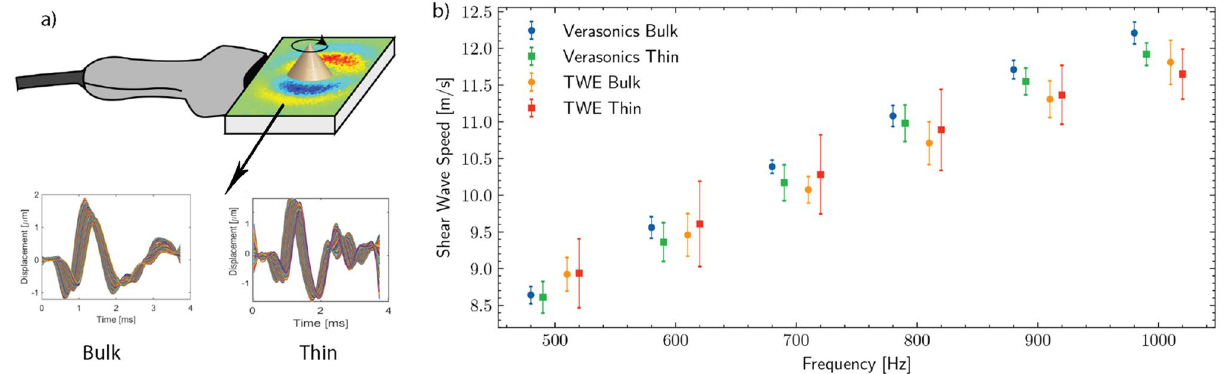
Figure 4. Exploring the torsional wave propagation under different geometries: ( a ) Shear wave imaging was performed on the horizontal plane of both thin and bulk polyacrylamide phantoms. The time profile of the displacements was similar for both geometries. ( b ) Comparison plot of TWE (torsional wave elastography) and verasonics (shear wave imaging) results. Verasonics validates both the values obtained and the negligible effect of guided waves. Results are displayed as mean ± standard